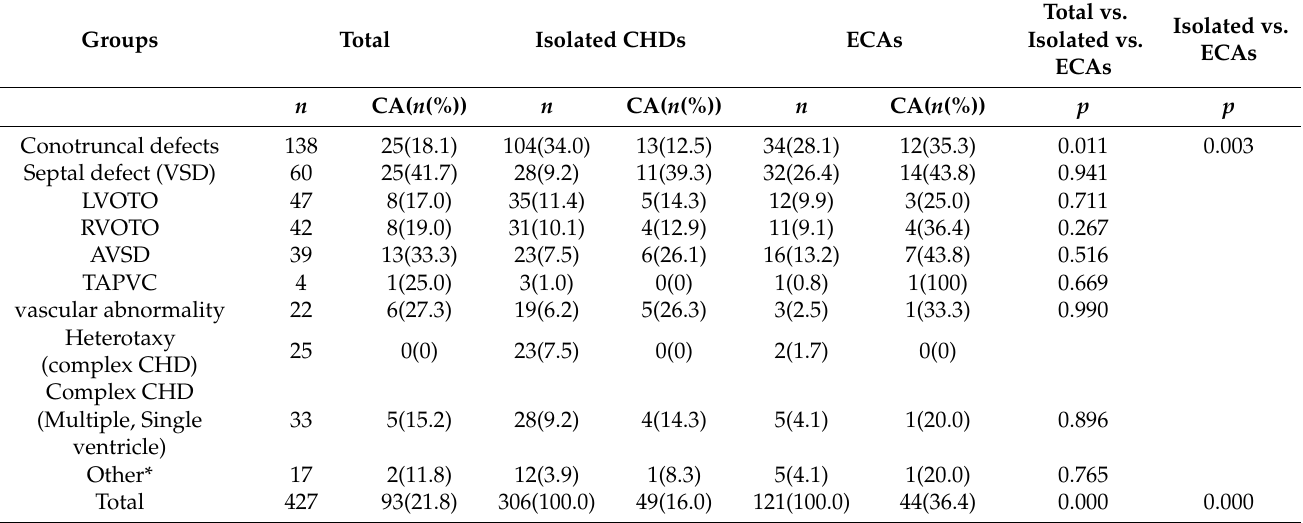
Table 1. Incidence of extracardiac abnormalities (ECAs) and chromosomal abnormalities (CA) found in 427 fetuses diagnosed with congenital heart defects (CHDs).